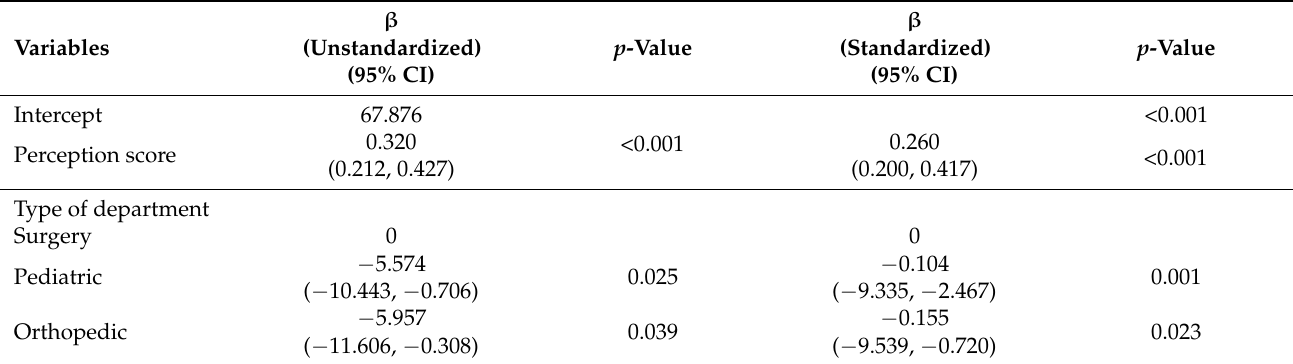
Table 4. Predictors of self-reported HH performance using multiple linear regression analysis ( n =